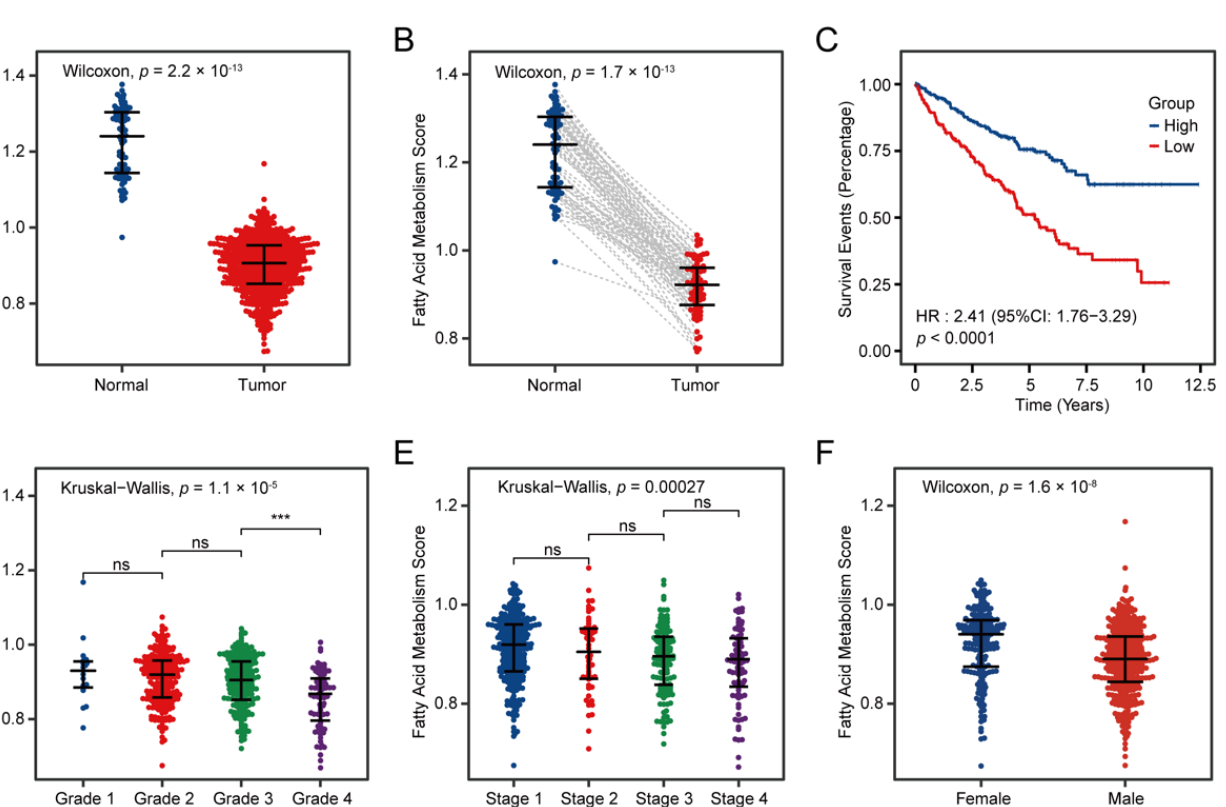
Figure 2. Clinical correlation of fatty acid metabolism pathway in patients with ccRCC. Beeswarm plots comparing the ssGSEA scores in all ccRCC samples and all adjacent normal tissues ( A ), paired ccRCC samples and adjacent normal tissues ( B ) and different tumor grades ( D ), AJCC stage ( E ) and gender ( F ). ( C ) Kaplan–Meier analysis showed that patients with lower ssGSEA scores of fatty acid metabolism exhibited worse OS. ccRCC: Clear Cell Renal Cell Carcinoma; ssGSEA: Single-sample gene set enrichment analysis; AJCC: American Joint Committee on Cancer; HR: Hazard ratio; CI: Confidence interval. p values less than 0.05 were considered to be statistically significant. ns: No significance, *** p < 0.001.